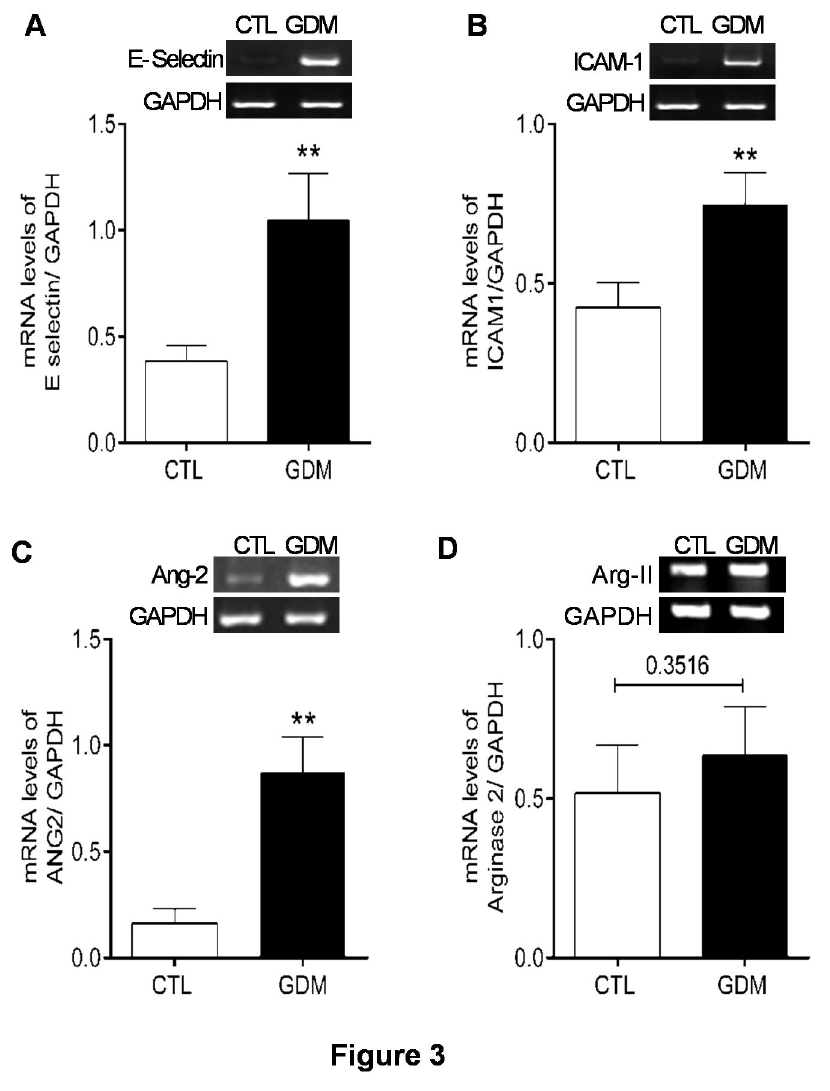
Figure 3. mRNA expressions profile of E-selectin, ICAM-1, Ang-2 and Arginase II in HUVECs. Increased mRNA expression of E-selectin (A), ICAM-1 (B), Ang-2 (C) and arginase II (D) with their representative gel pictures and cumulative bar graphs. RT- PCR analyses were done for 12 controls and 15 GDM subjects. **p≤0.01 versus control group. doi: